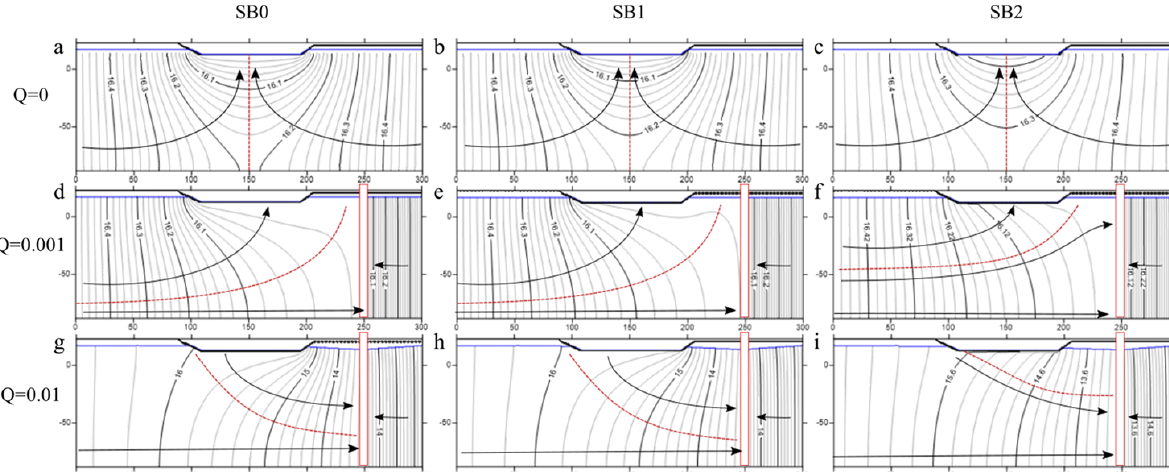
Figure 3. Modeling the 2D cross section of an alluvial plain for 100 m depth of aquifer (steady state flow) with different streambed hydraulic conductivities (left to right): Line 1 ( a – c ) without pumping (natural conditions symmetrical, Sim$1.1, Sim$1.4, Sim$1.7), line 2 ( d – f ) symmetrical case with pumping on the left (Q = 0.001, Sim$1.2, Sim$1.5 and Sim$1.8), line 3 ( g – i ) symmetrical case with pumping on the left (Q = 0.01, Sim$1.3, Sim$1.6 and Sim$1.9). The gray line represents the piezometric lines (0.1 m steps), the blue line represents the water table geometry, the black arrow represents the streamlines, and the red lines are the GW divide. With: SB0 no streambed clogging Ks = 1.10 −3 ms −1 , SB1 streambed clogged: Ks = 1.10 −4 m s −1 , SB2 ms −1 streambed clogged: KS = 1.10 −5 ms −1 .